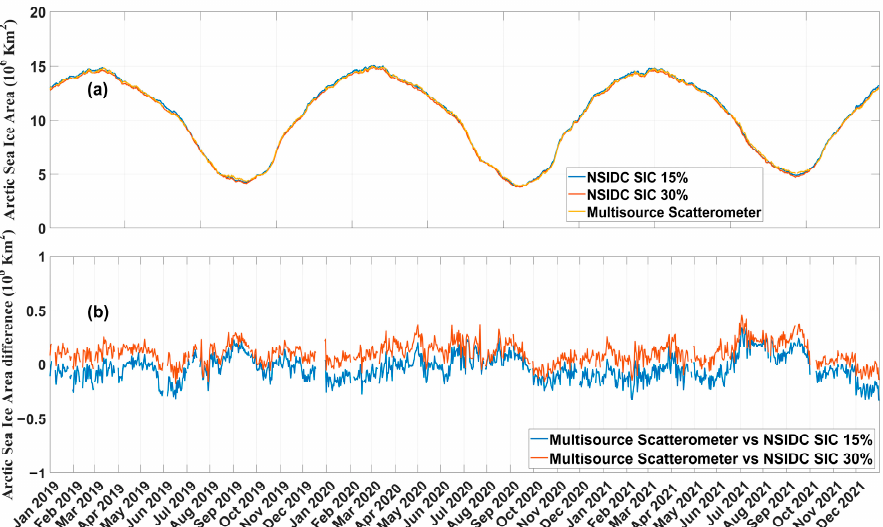
Figure 9. The validation results of the Arctic from 2019 to 2021; ( a ) daily sea ice area for NSIDC SIC 15% ice extent (blue line), NSIDC SIC 30% ice extent (red line), and multisource scatterometer (yellow line), respectively, and ( b ) sea ice area difference between multisource scatterometer and NSIDC SIC 15% (blue line), and between multisource scatterometer and NSIDC SIC 30% (red line).